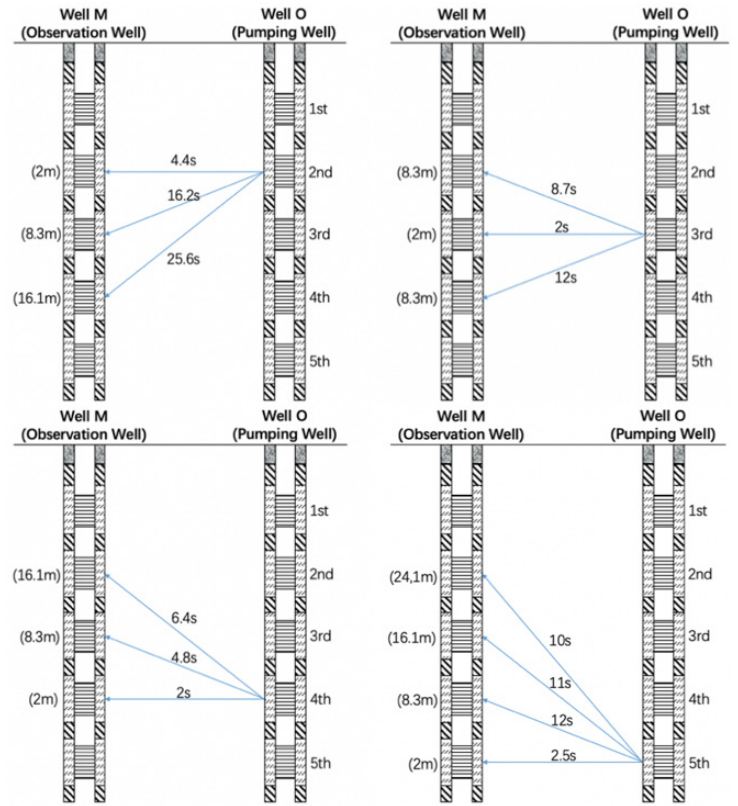
Figure 14. Data processing of a set of field data.